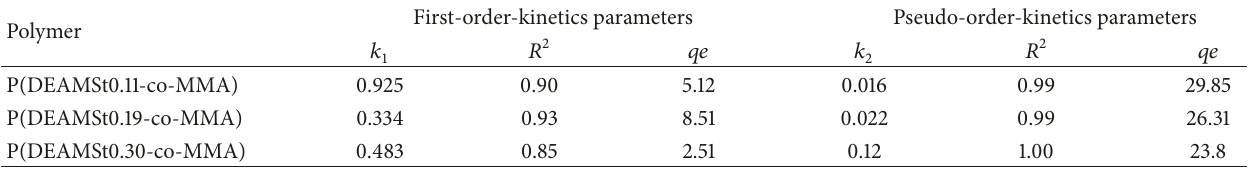
Table 5: The kinetic parameters for BCK on P(DEAMSt-co-MMA).